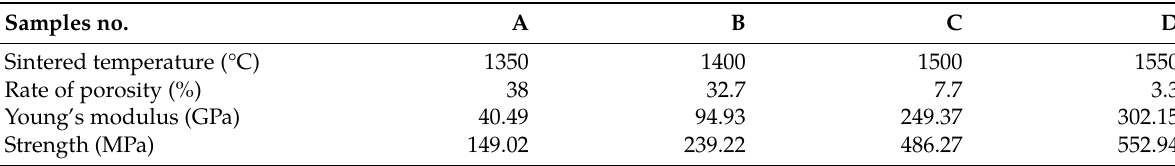
Table 1: A summary of the obtained samples. Samples